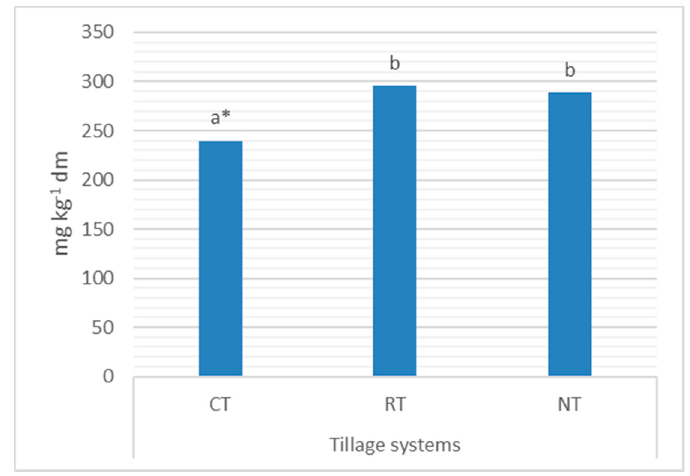
Figure 8. Content of phosphorus (P) in the 0–25 cm soil layer depending on the tillage system (average of 2014–2016). * a—Means denoted with the same letters do not differ significantly, p < 0.05. Agriculture 2020 , 10 , x FOR PEER REVIEW